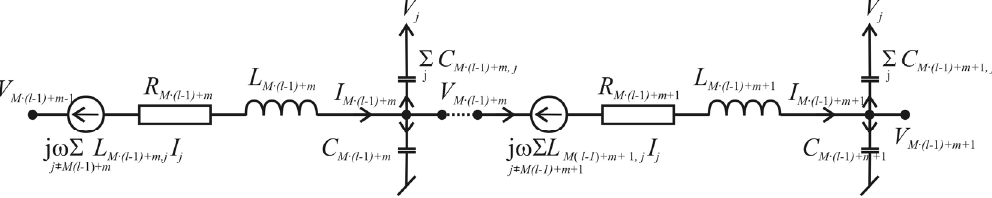
Figure 2. Single network element with couplings to the next turns.